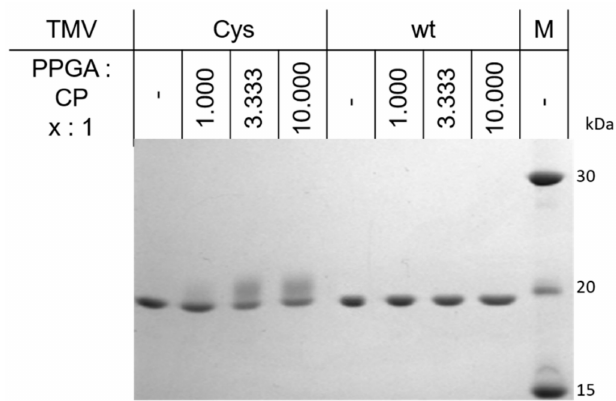
Figure 3. Silver-stained 15%-SDS-PAGE showing the coupling e ffi ciency at di ff erent ratios of PPGA to CP using TMV-Cys and no coupling of PPGA to wt-TMV. The product of the conjugation reaction can be seen as a smear above the CP band at about 20 kDa.